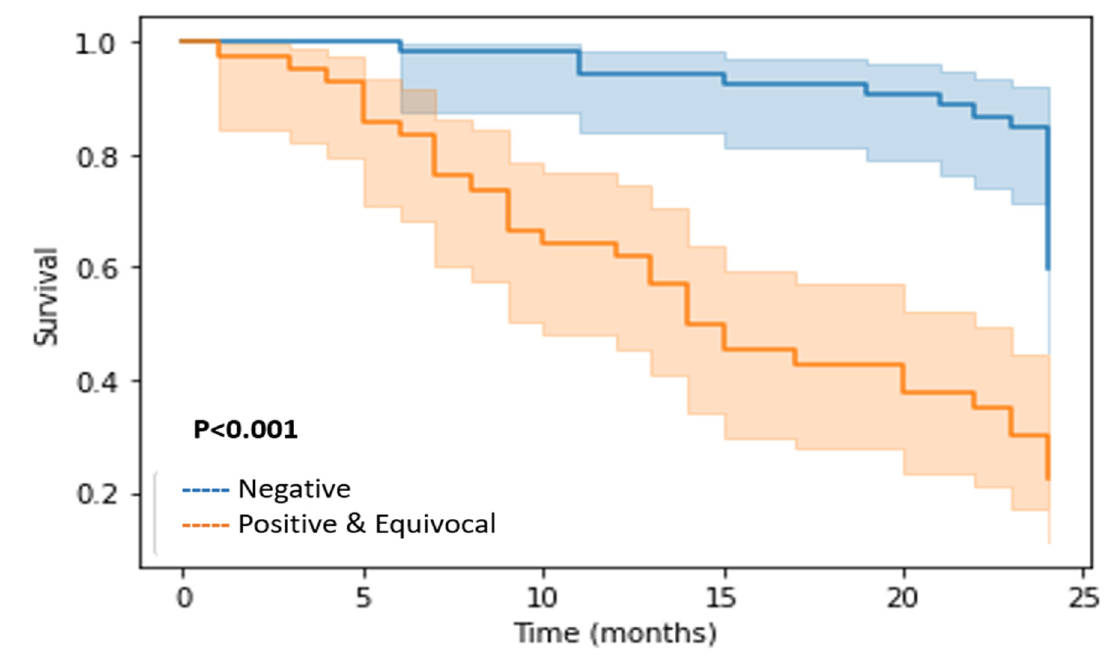
Figure 3. Kaplan–Meier (K-M) curve for two-year survival (OS). K-M curve for two-year OS comparing negative scans versus equivocal and positive scans grouped together.